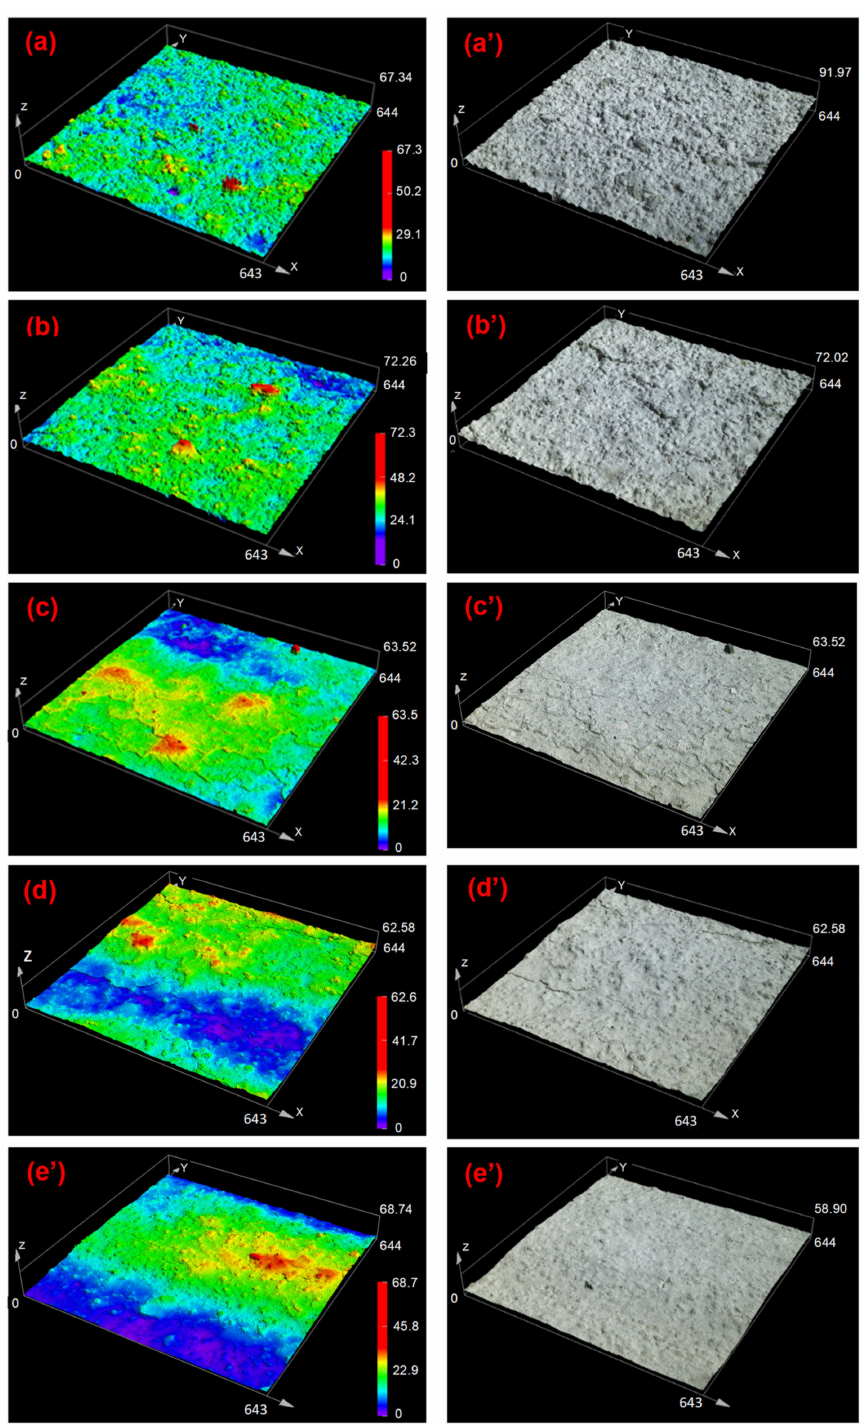
Figure 5. 3D micrographs of coatings recorded by CLSM at magnification 20 × (size of analyzed spots [640 × 640] µ m 2 ): SW1 ( a , a’ ), SW2 ( b , b’ ), SW3 ( c , c’ ), SW4 ( d , d’ ), and SW5 ( e , e’